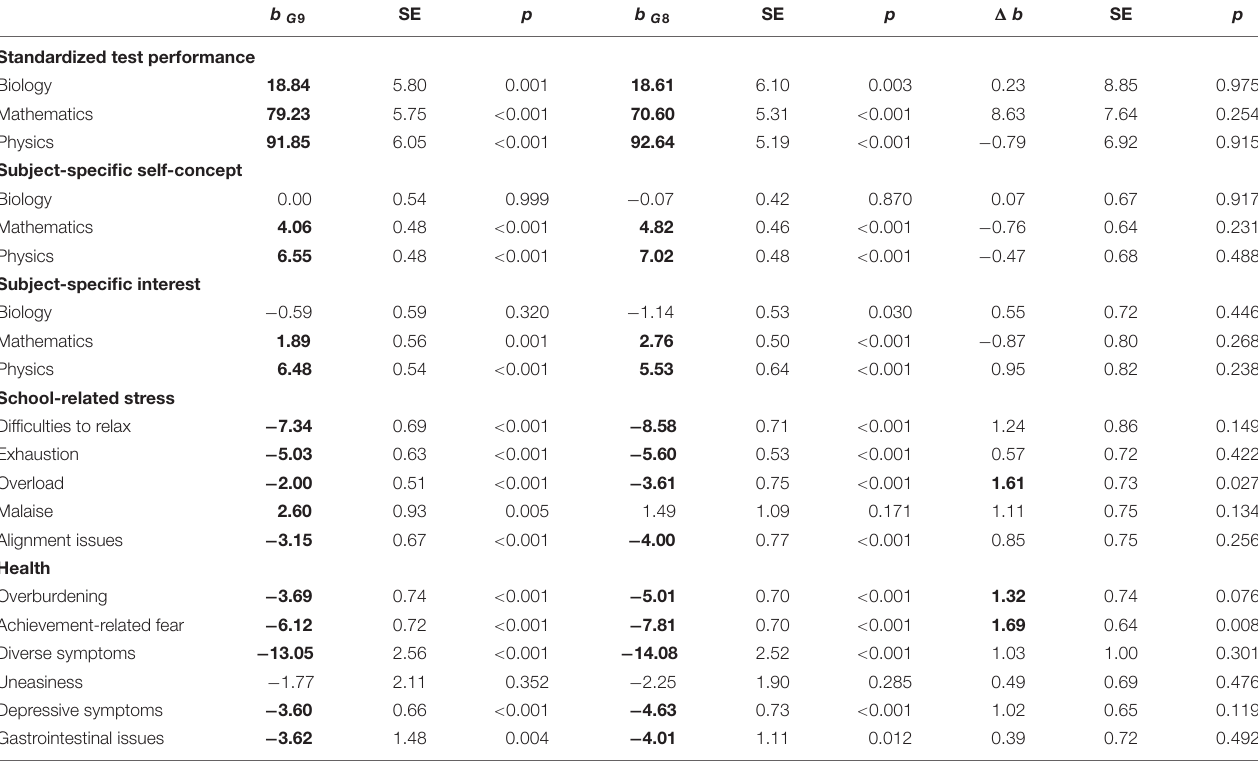
TABLE 2 | Unadjusted gender-disparities before and after the reform on standardized test performance, subject-specific self-concept and interest, and school-related stress and